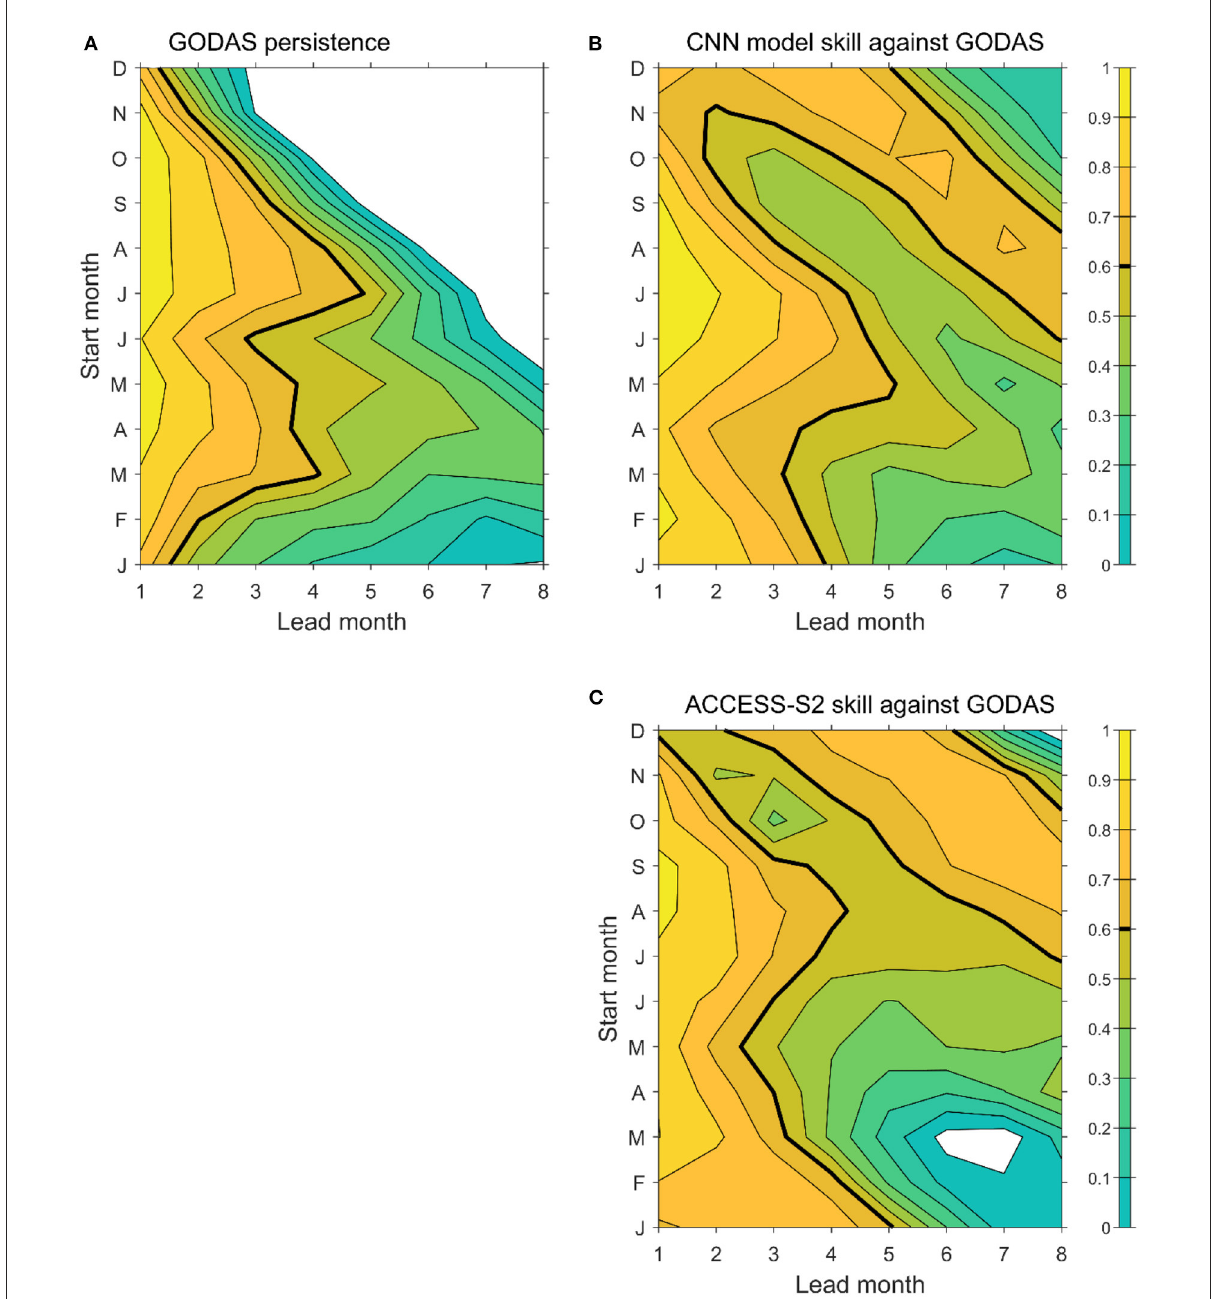
FIGURE9 Intercomparison between the persistence and prediction skills for eastern IOD SST anomalies of the CNN model and ACCESS-S2: (A) persistence from GODAS, (B) correlation prediction skills of the CNN model, and (C) correlation prediction skills of ACCESS-S2. Negative skills are not plotted and skills of 0.6 are denoted by bold contour lines. The persistence and CNN model skill are interpolated to be consistent with the ACCESS-S2 lead time. See the correlation numbers in Supplementary Tables